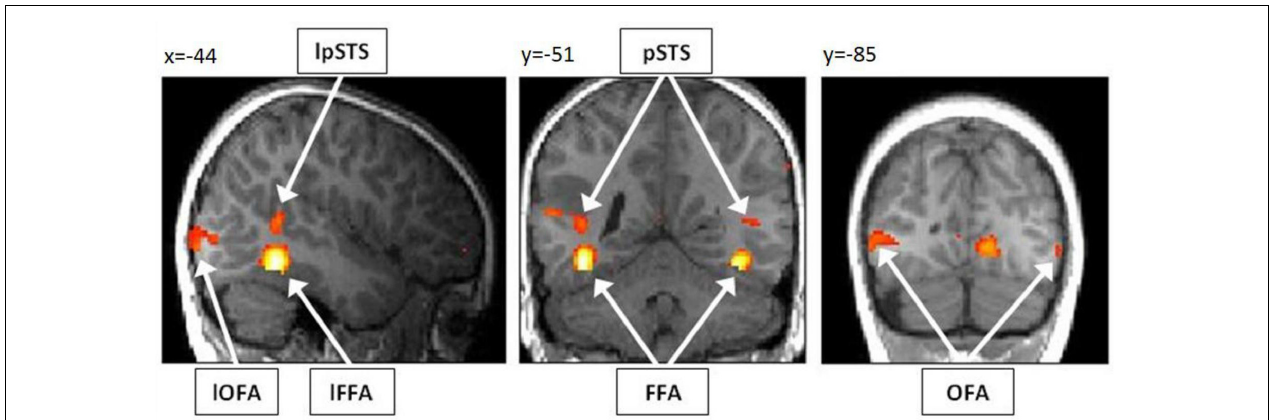
FIGURE 4 | Activation pattern of a representative child (7 years, male) for the contrast “faces > houses.” As overlay T1 image, the normalized and smoothed structural T1 scan of the respective child was used. The subject shows clearly discernible activity in bilateral OFA, FFA and pSTS. For illustrational purposes, the activation pattern is thresholded at p < 0.001, uncorrected for multiple comparisons. Note, however, that all six activations were significant for multiple comparisons ( p < 0.05 FWE corrected) at the predefined ROI masks for bilateral OFA, FFA, and pSTS. OFA, occipital face area; FFA, fusiform face area; pSTS, posterior superior temporal sulcus; l, left.